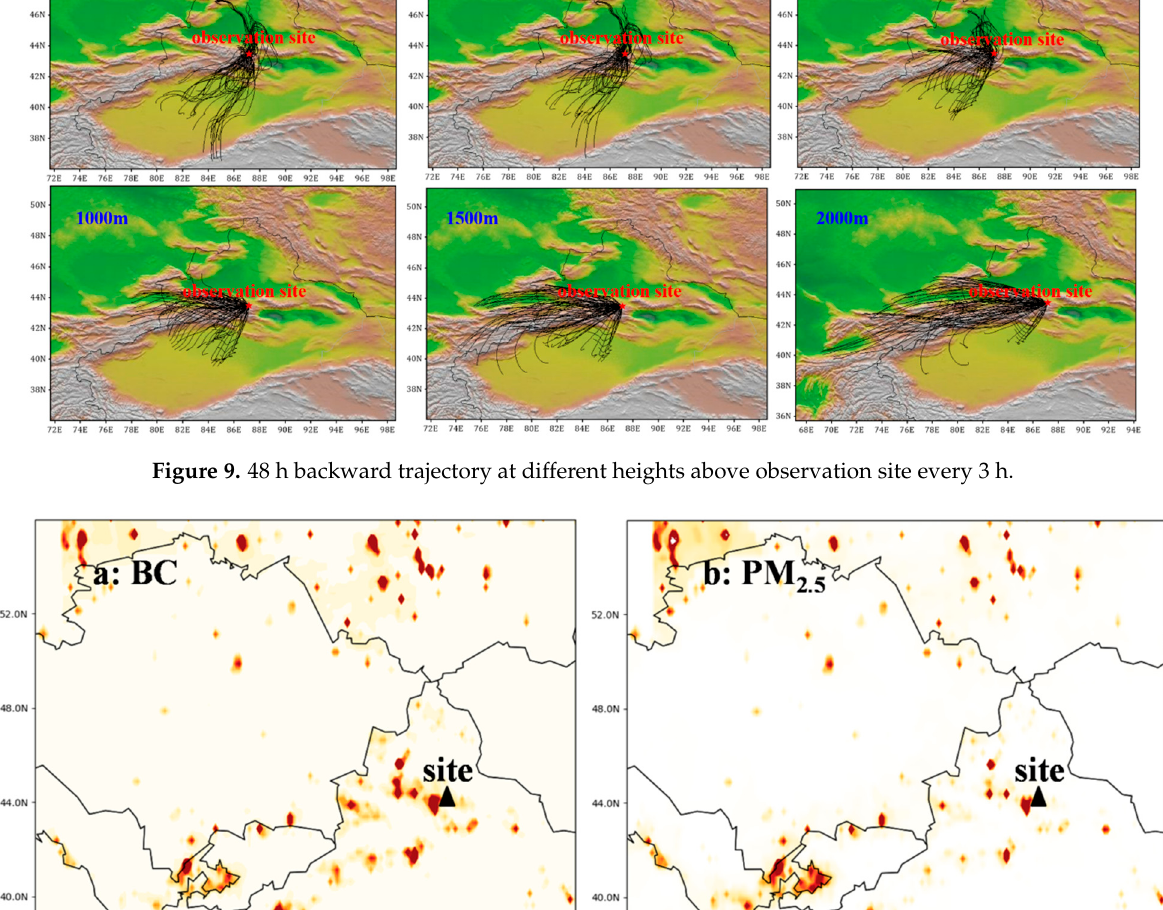
Figure 9. 48 h backward trajectory at different heights above observation site every 3 h.